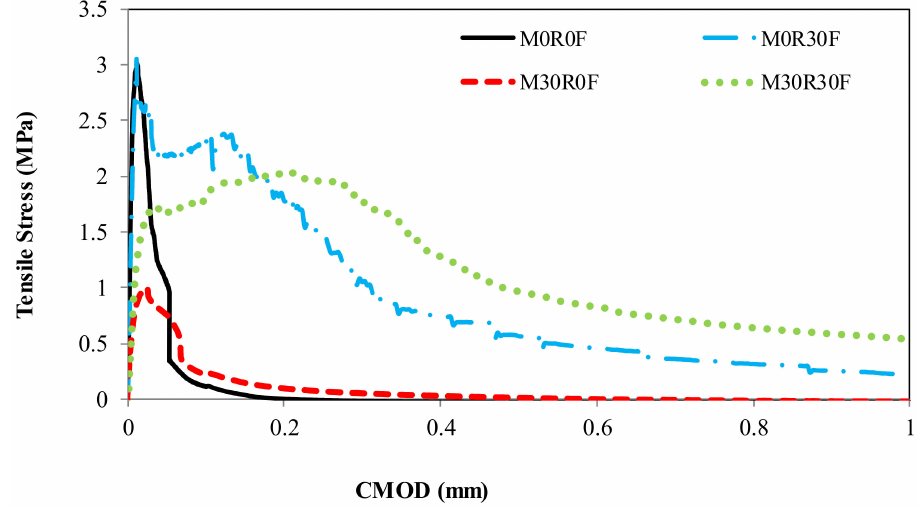
Figure 12. Impact of rubber aggregates and fibres on strain capacity and on residual post- peak strength.